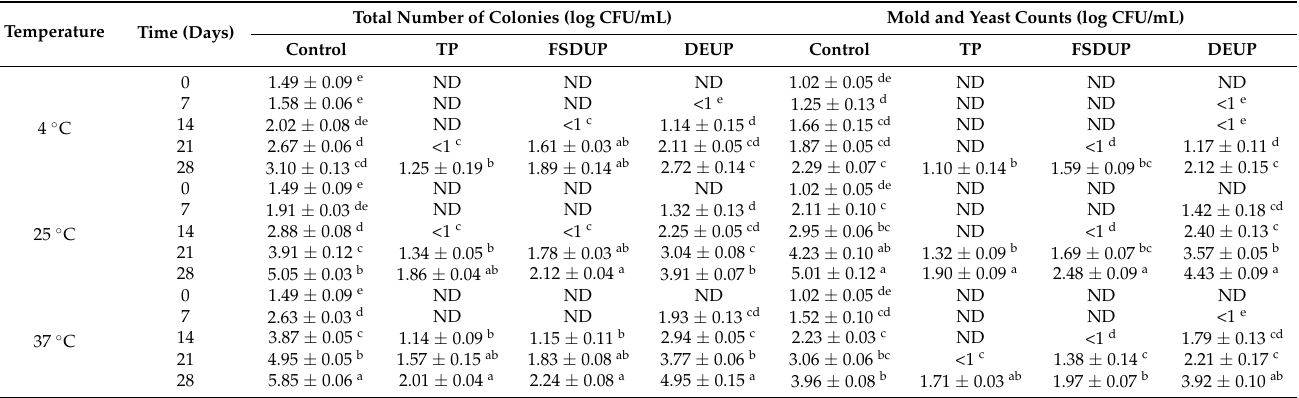
Table 1. Changes in microbial population in strawberry clear juice during storage after thermal pretreatment and multi-mode